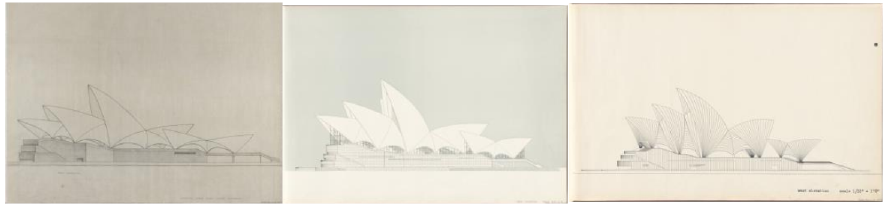
Figure 10. Design evolution. From left to right elevations drawing from 1956 (Brown Book, compe- tition proposal), 1958 (Red Book, elliptical geometry), and 1962 (Yellow Book, spherical geometry) (www.records.nsw.gov.au; last accessed 2 December 2021)